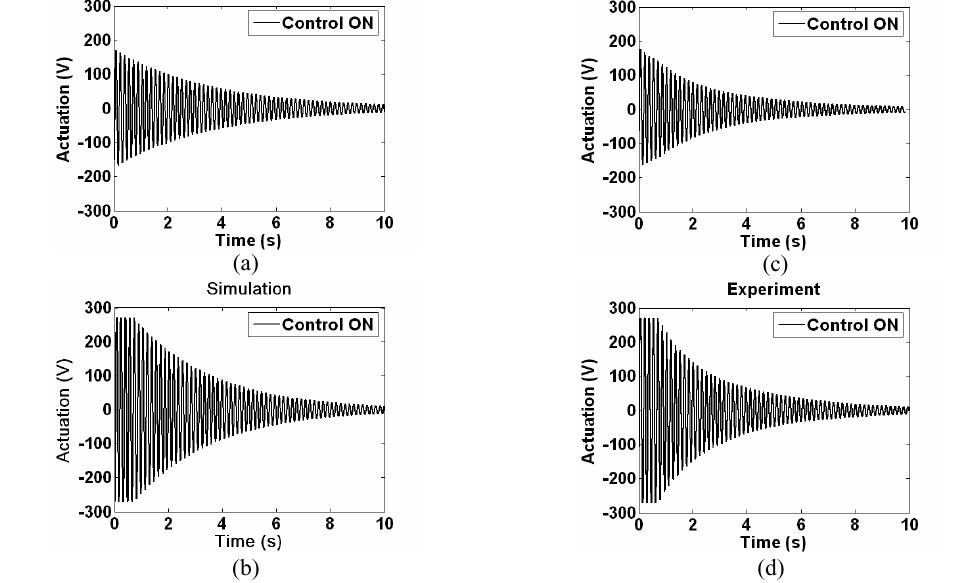
Fig. 11. Case 1 actuation voltages for displacement feedback